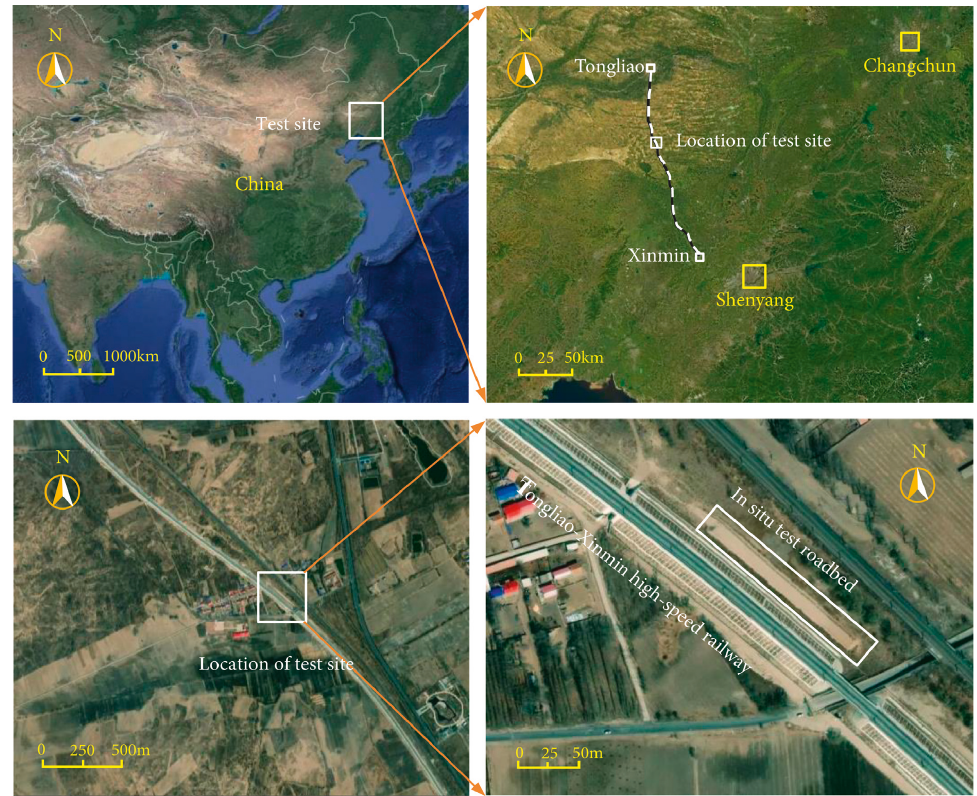
Figure 1: Geographical location of the test